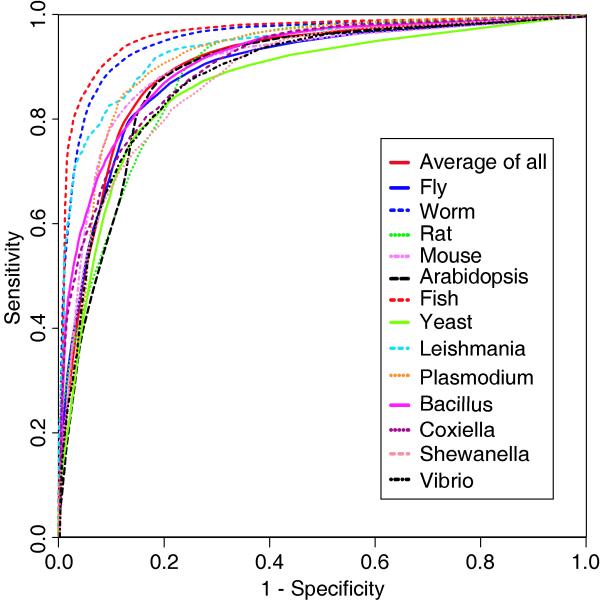
ROC plots for the classifiers performance: ROC plots for the results of all organisms tested and the average of all test sequences. The classification performance for different classes of organisms like multi-cellular eukaryotes, single-cell eukaroyotes and the prokaryotes were compared.